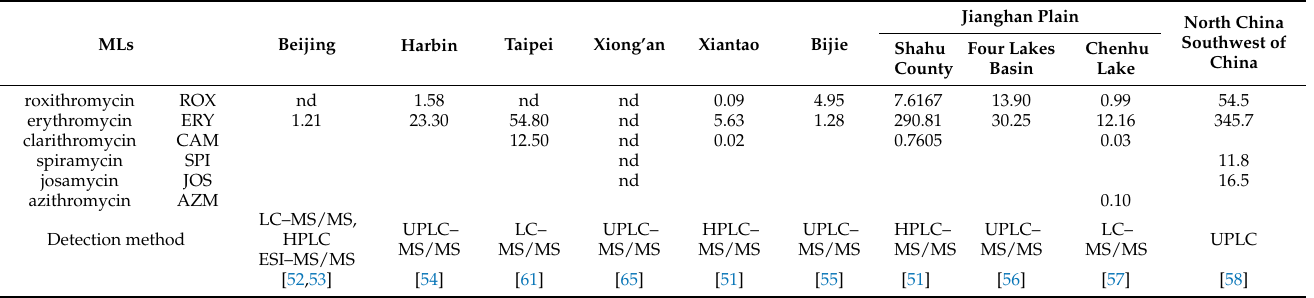
Table 4. MLs and their concentrations detected in groundwater of China (ng/L), and the detec- tion